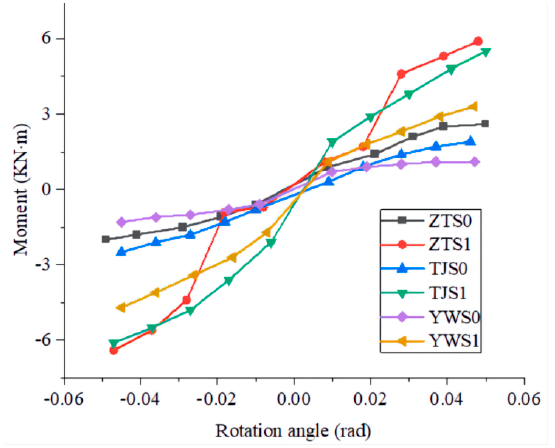
Figure 10. Skeleton curve of each joint